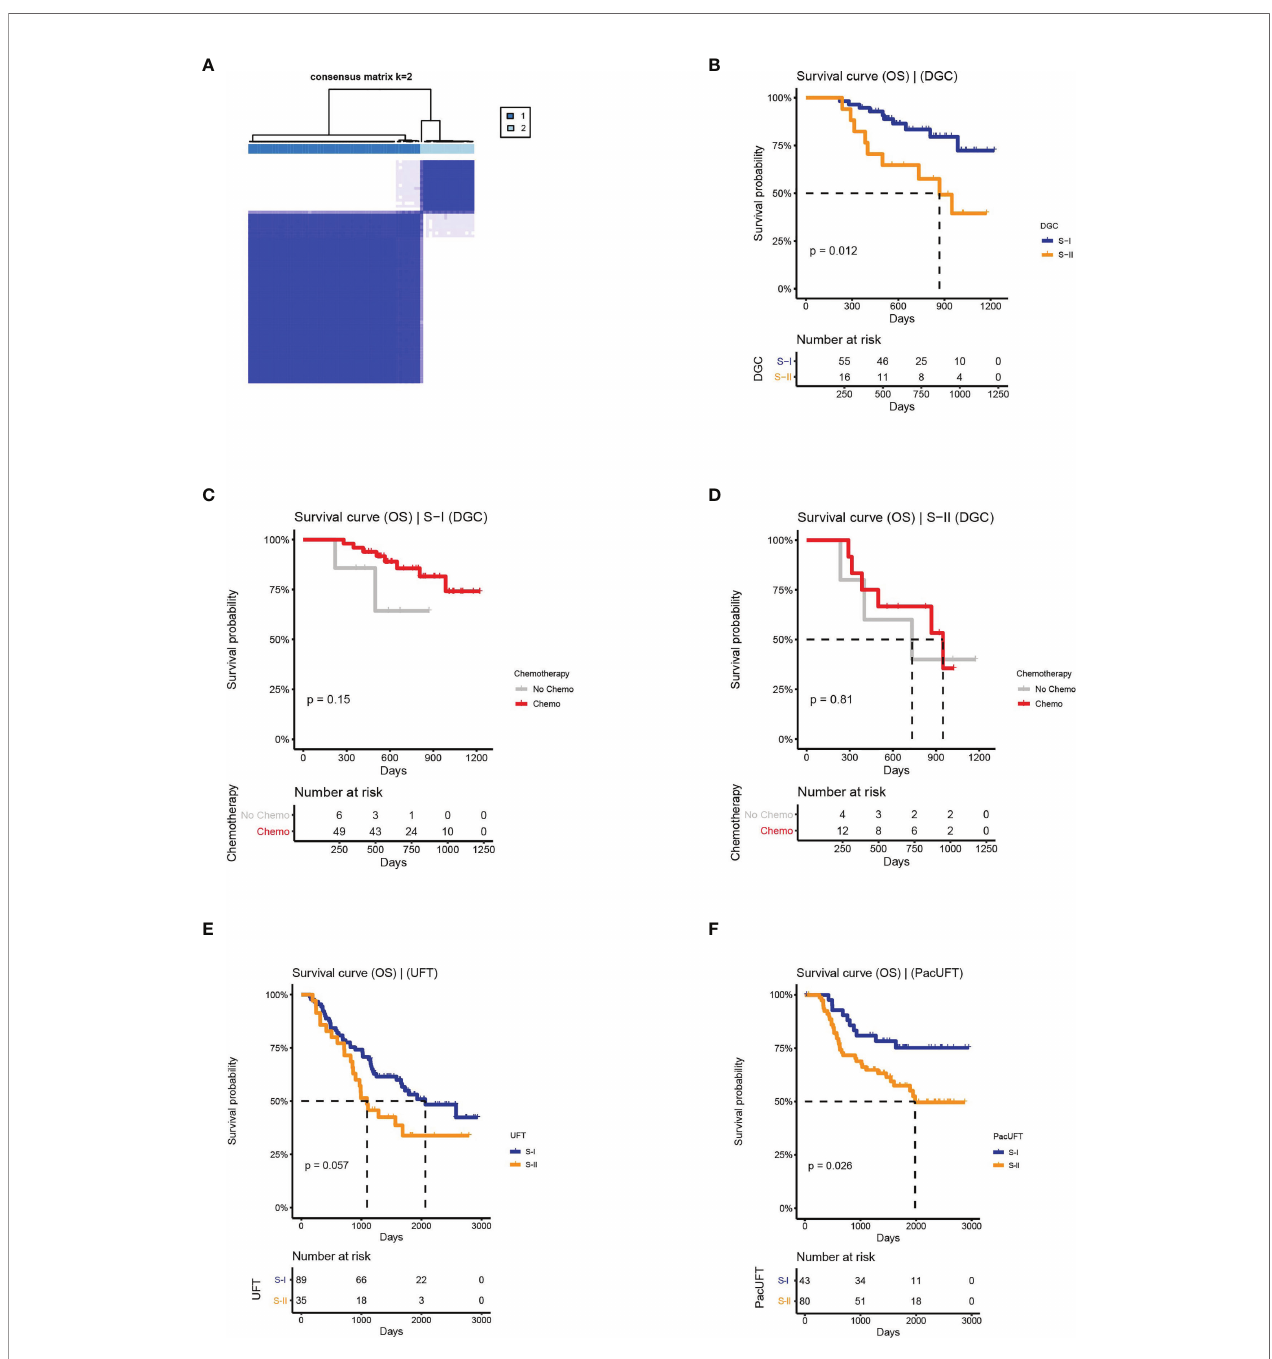
FIGURE 5 | The clinical outcomes of molecular subtypes obtained by the protein features transformed from AE in the external validation set. (A) The clustering result of DGC. (B) The OS of S-I and S-II. (C, D) The OS by chemotherapy status for S-I and S-II. (E) The OS of molecular subtypes for UFT-treated and. (F) PacUFT-treated patients in the external validation